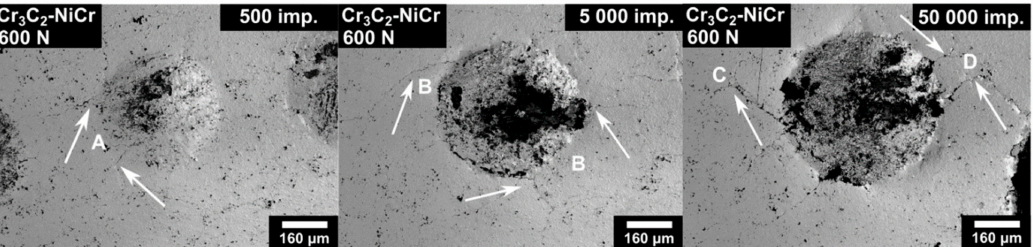
Figure 6. Dynamics of the microcracks spreading illustrated on the Cr 3 C 2 -25%NiC coating.